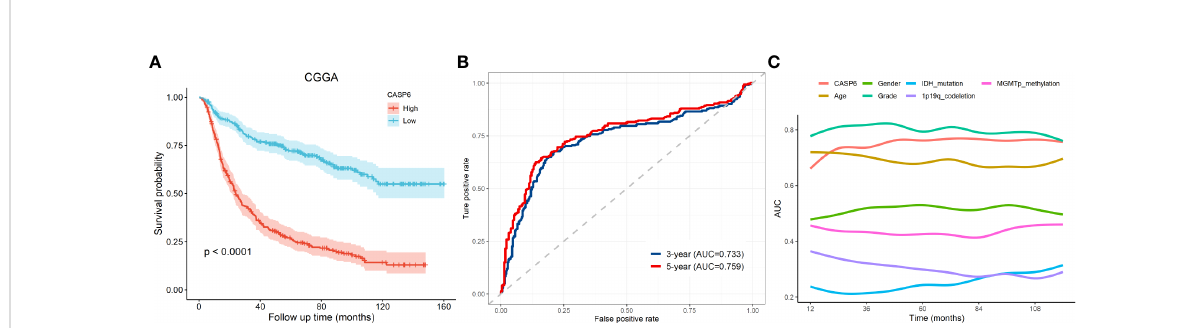
FIGURE 2 The prognostic value of CASP6 in the CGGA database. (A) Kaplan-Meier survival analyses of overall survival and CASP6 in patients with glioma in the CGGA database. (B) ROC curve analysis to evaluate the prognostic value of CASP6 expression in glioma in terms of survival at 3 years and 5 years. (C) AUC analysis to evaluate the prognostic value of CASP6 expression in